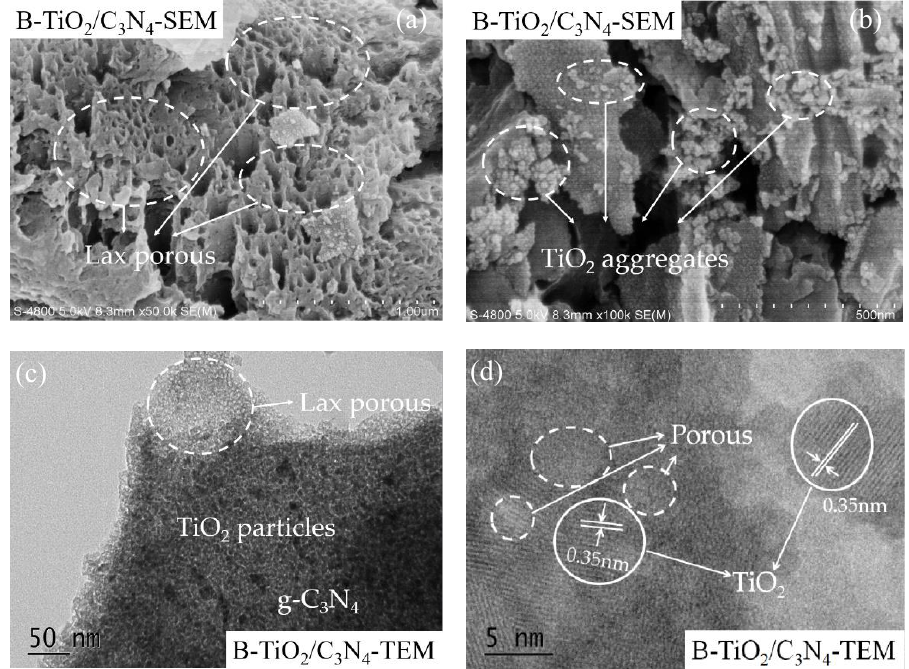
Figure 2. SEM ( a , b ) and TEM ( c , d ) spectra of B-TiO 2 /C 3 N 4 (550 °C) composite materials.